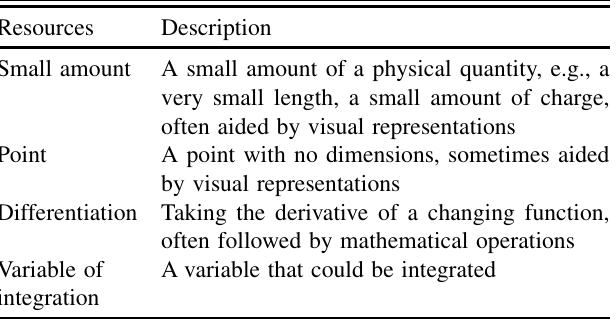
TABLE II. List of conceptual metaphors associated with the use of